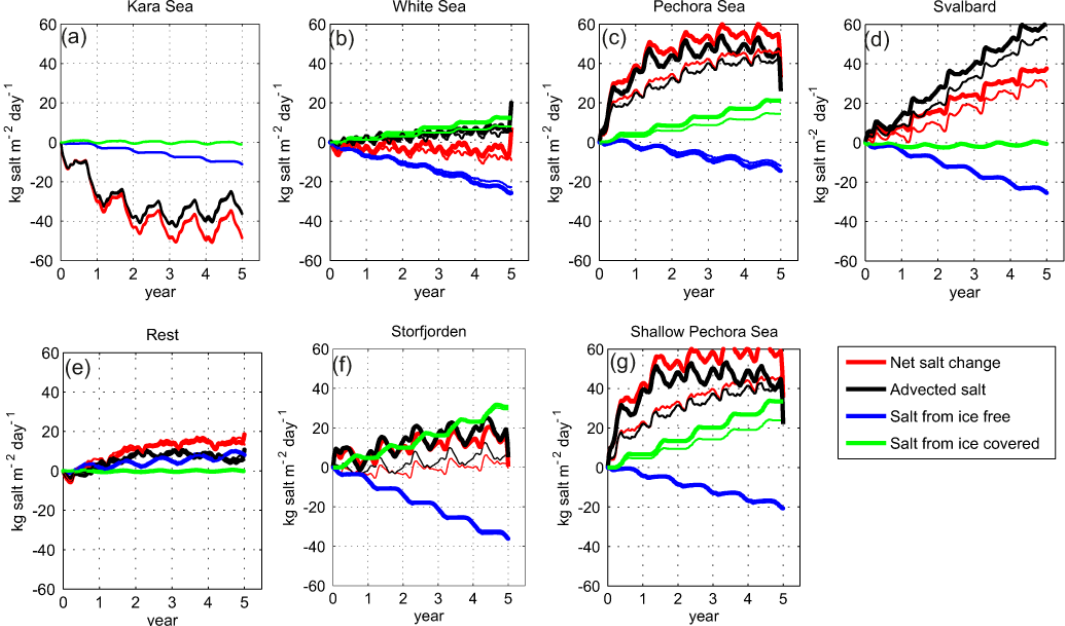
Fig. 10. Time series of the change in vertically integrated salt content (kg salt m − 2 ) relative to the initial salt content, S 0 (red). Daily means have been spatially averaged over the five subdomains shown in Fig. 2b and two additional subdomains; Storfjorden and the shallow Pechora Sea. The contribution to vertically integrated salt content from lateral advection (black), surface fluxes from ice free regions (blue) and surface fluxes from ice covered regions (green) are also shown. Thick lines show results from the model run including tides and thin lines are from the control run. A thirty day running mean has been applied to remove high frequency variation and highlight the trends. Initial values are S 0 = 2714kgm − 2 (Kara Sea), 1811kgm − 2 (White Sea), 1379kgm − 2 (Pechora Sea), 3883kgm − 2 (Svalbard), 7862kgm − 2 (Barents Sea), 771kgm − 2 (Storfjorden) and 708kgm − 2 (shallow Pechora